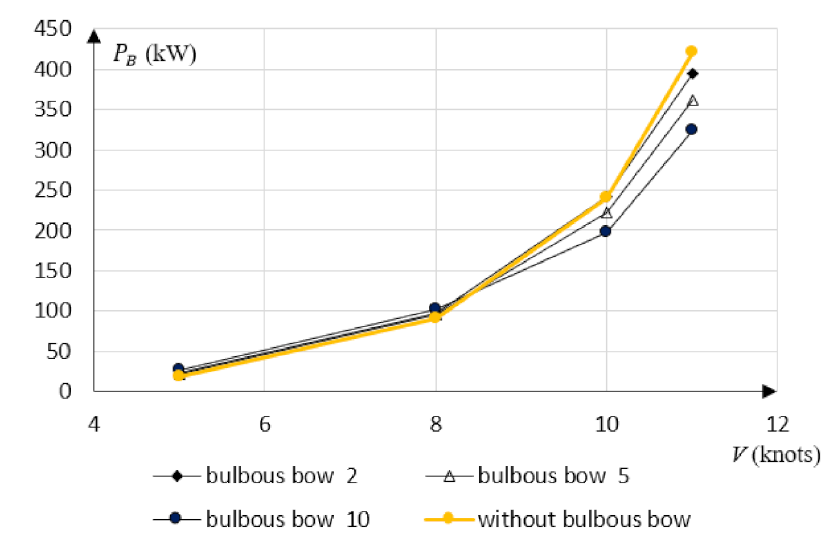
Figure 11. Engine load as a function of vessel speed, for the adopted bulbous